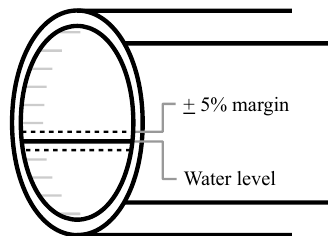
Figure 2. Illustration of the 5% point uncertainty margin allowed in the annotations. The gray horizontal lines in the left side of the pipe indicate the discrete steps from 0% to 100%. A water level of 40% is present in the given